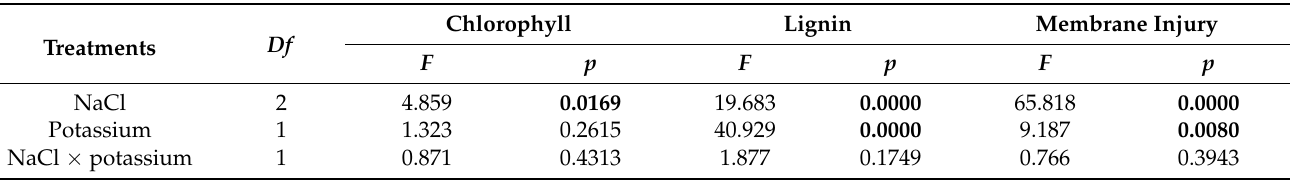
Table 5. ANOVA results for leaf chlorophyll and lignin content and membrane injury index in zinnia exposed to salinity with two potassium levels in the peat